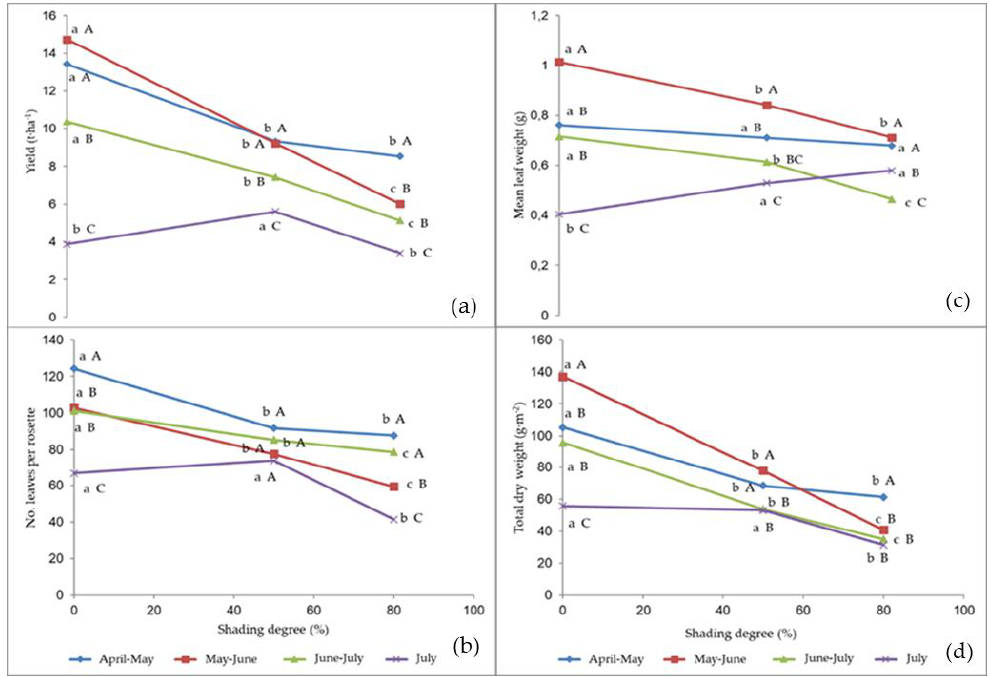
Figure 2. Interaction between cropping season and shading degree on: ( a ) leaf yield; ( b ) leaf number per rosette; ( c ) mean leaf weight; ( d ) total dry weight. Values followed by di ff erent letters are significantly di ff erent according to the Duncan test at p ≤ 0.05. Lowercase letters refer to the comparison between the shading treatments within each cropping season, and capital letters refer to the comparison between cropping seasons within each shading treatment.